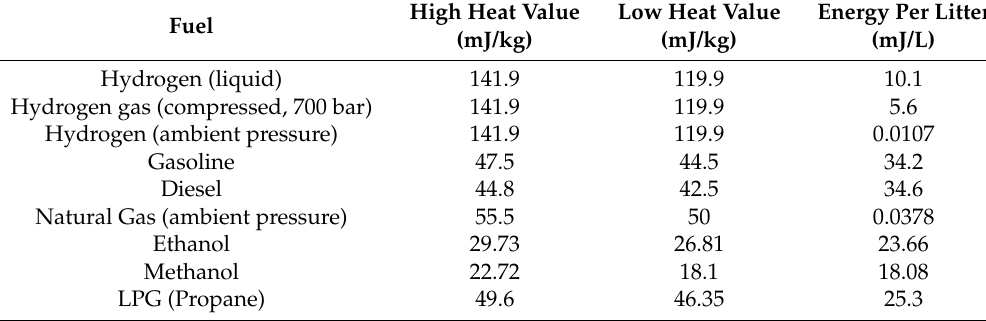
Table 2. Volumetric and gravimetric energy densities of fuels used in automotive transport